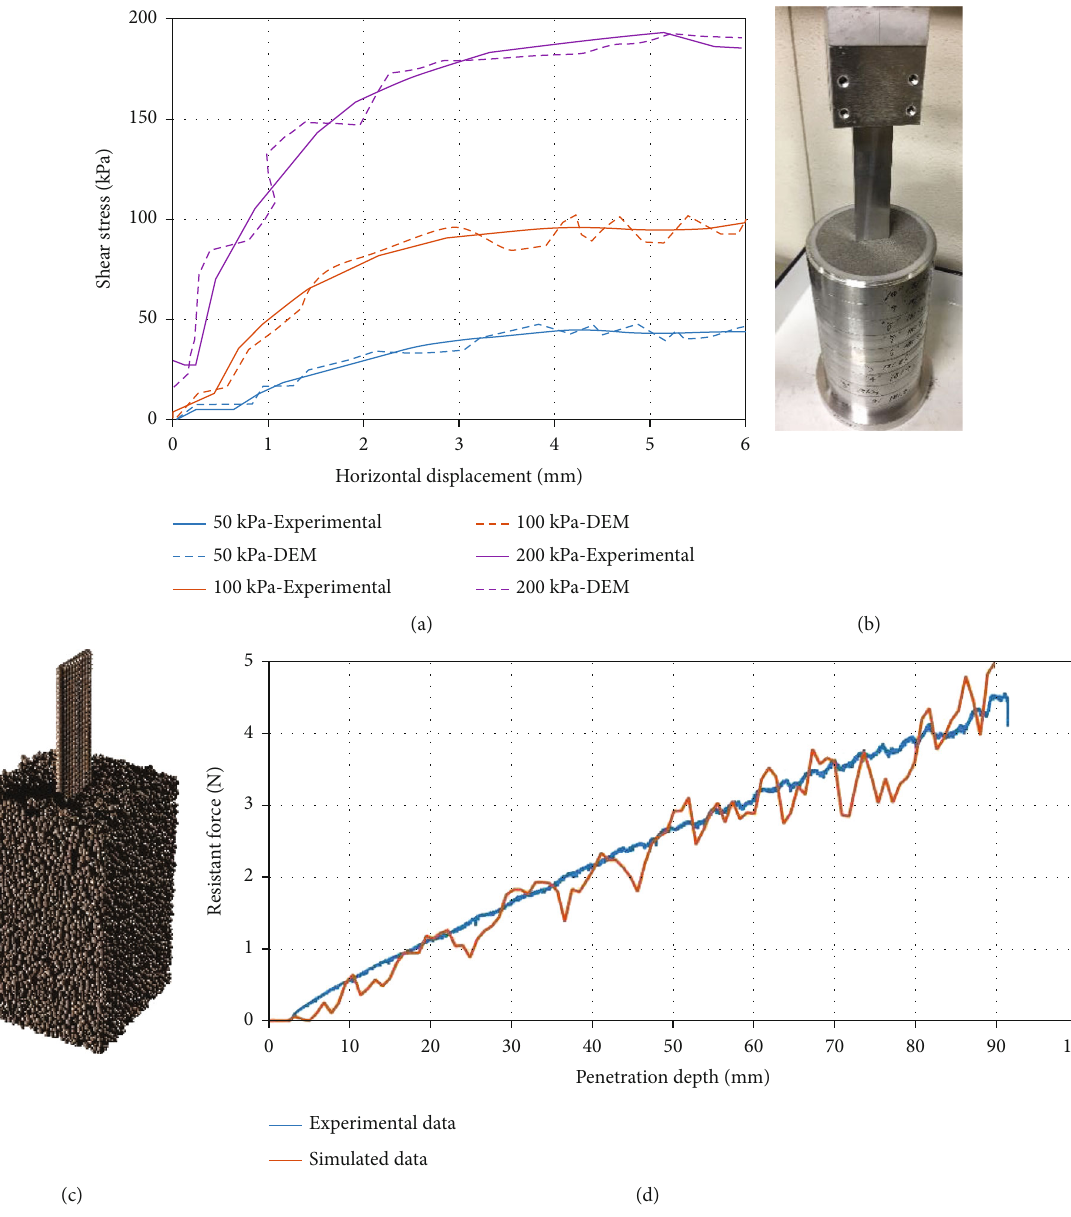
Figure 6: Dynamic validation for DEM lunar soil simulant ((a) direct shear tests validation, (b) actual penetration experiment, (c) DEM penetration experiment, and (d) comparison between the actual and DEM penetration